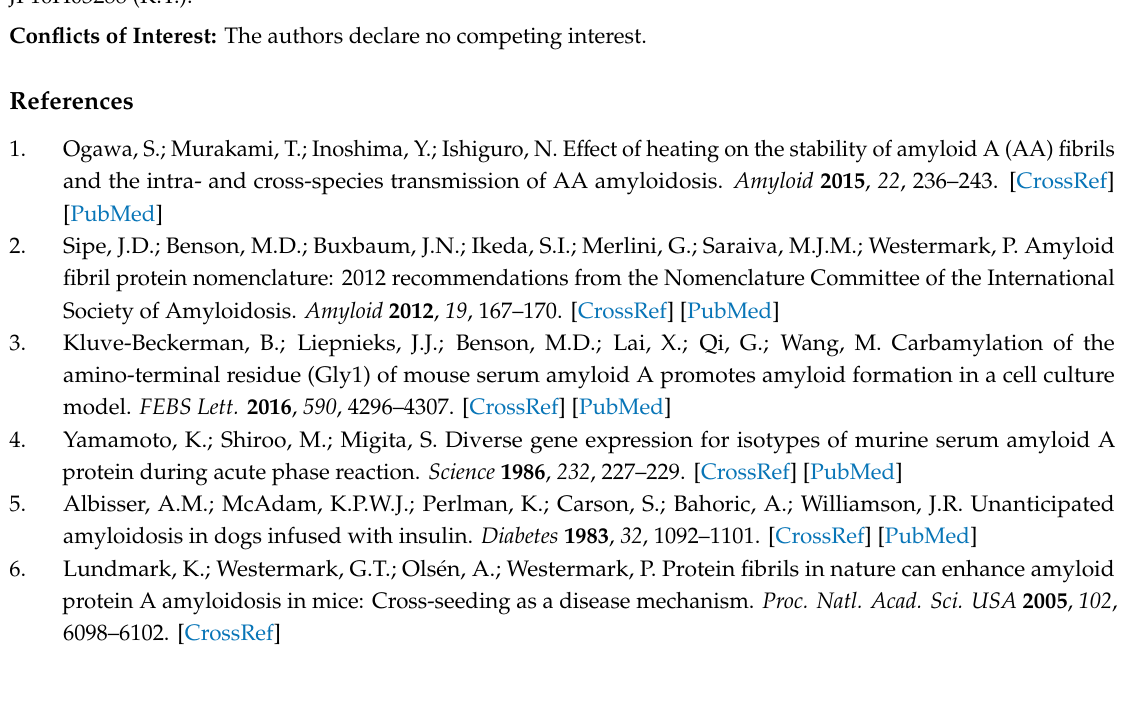
Figure S1. A flow diagram of the microliter-scale high-throughput screening system. Figure S2. Determination of the optimal SAA protein concentration. Figure S3. Transmission electron microscopic observation of RA-treatment sample and control. Figure S4. SAA aggregate disruption experiments by RA. Figure S5. A β aggregation inhibitory activity of Melissa o ffi cinalis extract containing RA. Figure S6. Amyloid deposition in mouse spleen. Figure S7. Full imaging of amyloid deposition in mouse organs (liver and spleen) with or without ME